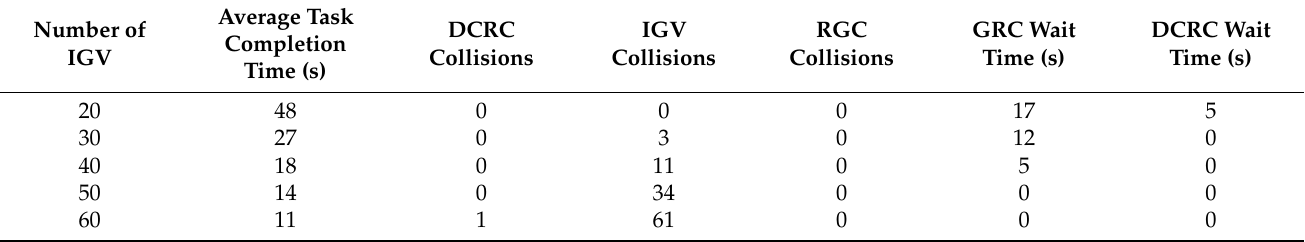
Table 5. Operation efficiency evaluation indexes of 50